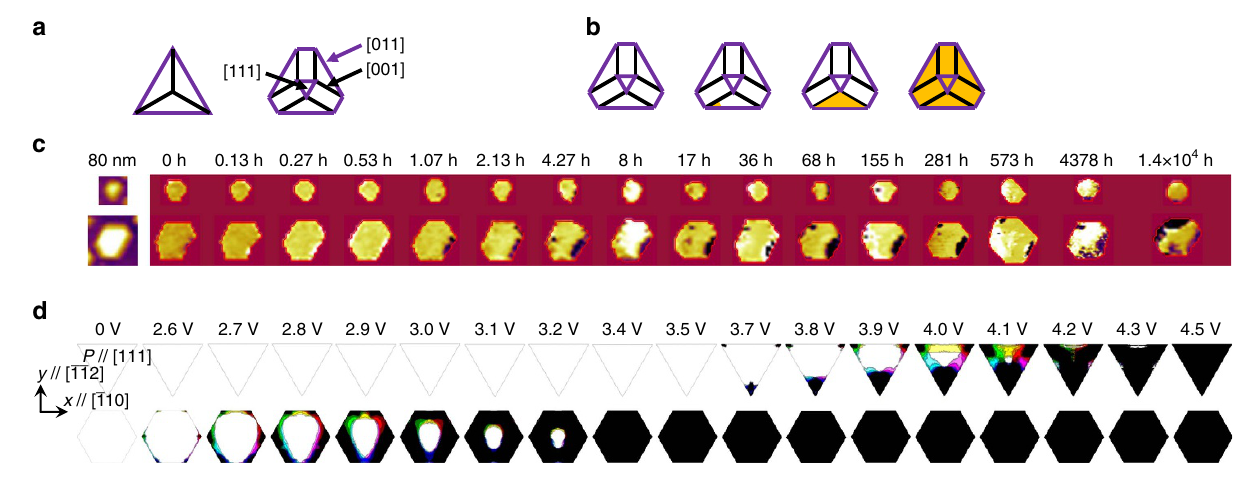
Figure 3 | Different relaxation processes. The schematics of ( a ) different shapes of BFO mesocrystal and ( b ) the evolution of relaxation process. ( c ) The relaxation process of BFO mesocrystal of different sizes as a function of time. ( d ) Switching process of different BFO mesocrystal shapes from the phase-field simulations, where white and black regions are ferroelectric domains with upward and downward polarization, respectively. Lateral area of the triangle and hexagonal mesocrystals are 0.01 and 0.04 m m 2 , respectively. In the simulations, the electrostatic potential increases step by step, and the results are compared with experiments after different